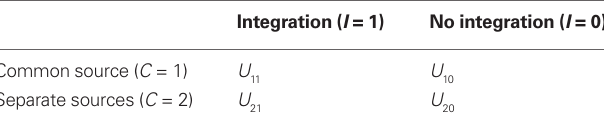
Table  | Payoff matrix for the basic decision